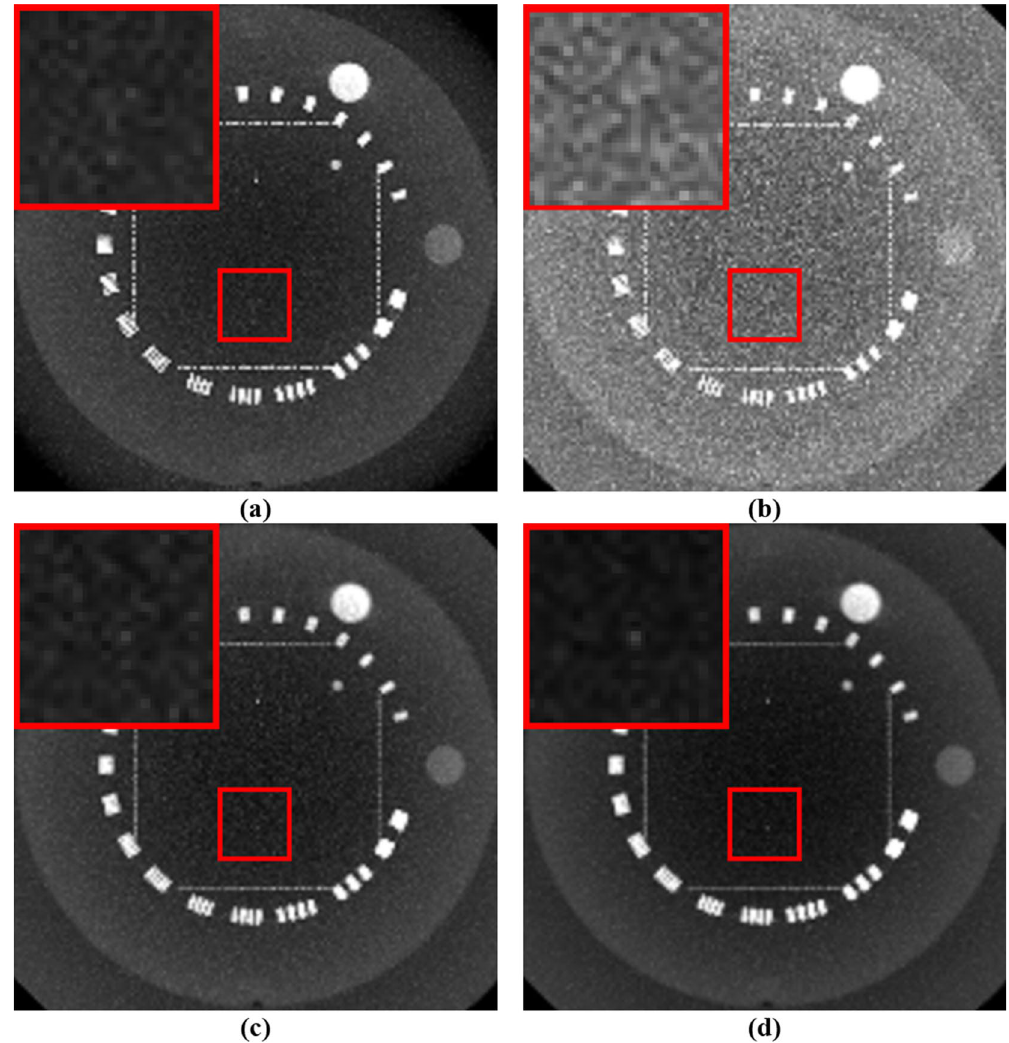
Figure 9. Comparison of MIP of ( a ) low resolution benchmark CBCT images with a high mAs and low resolution CBCT reconstruction images generated by applying FDK algorithms with ( b ) SL + cubic B-spline, ( c ) ATV + cubic B-spline, and ( d ) NLTV + cubic B-spline using Catphan503 phantom acquired under a low mAs. These images are displayed at window (width and level) settings of (1100, 500)